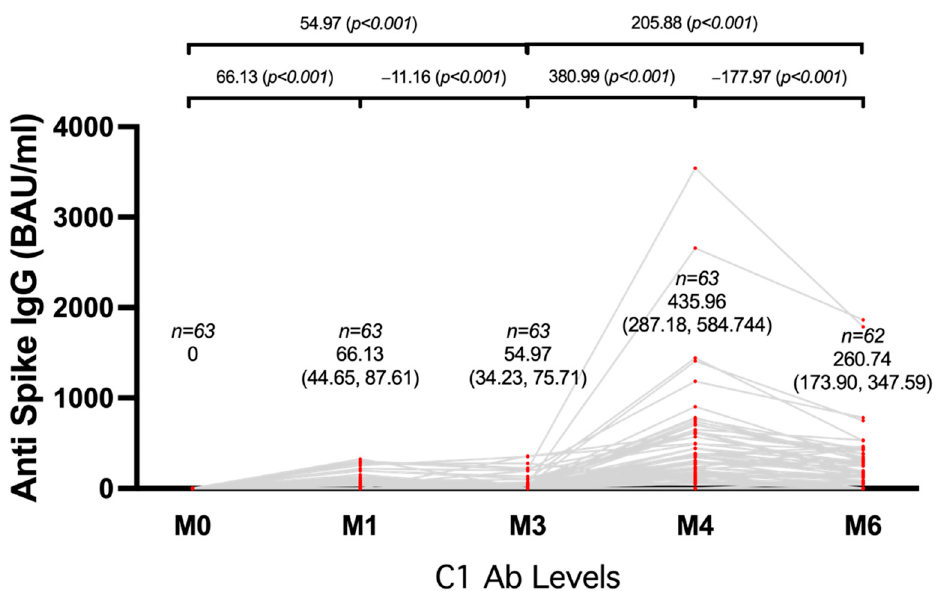
Figure 2. Changes in anti-spike IgG were evaluated at baseline (M0), 1 month, and 3 months after each shot in 63 ESRD with HD patients who received two shots of ChAdOx1 nCoV-19, and is presented as BAU/mL. BAU stands for binding antibody units, and IgG stands for immunoglobulin G.